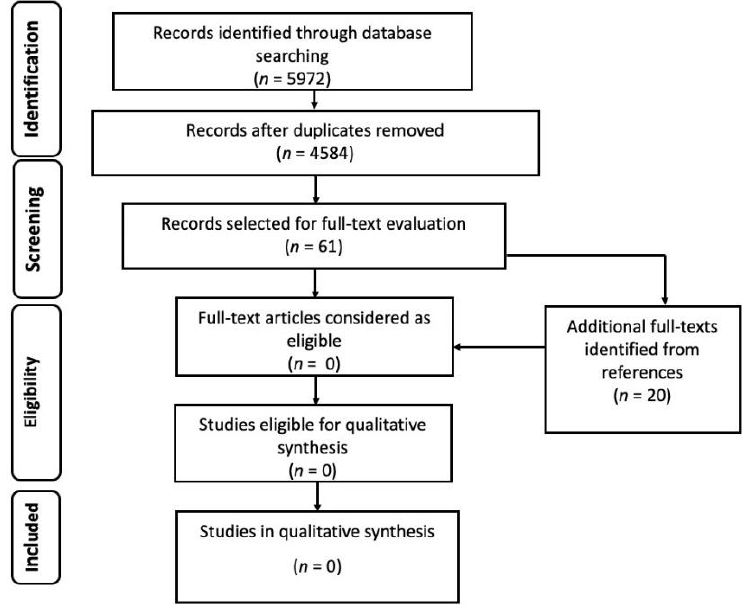
Figure 3. Flow diagram of the study selection process for other invasive fungal diseases.